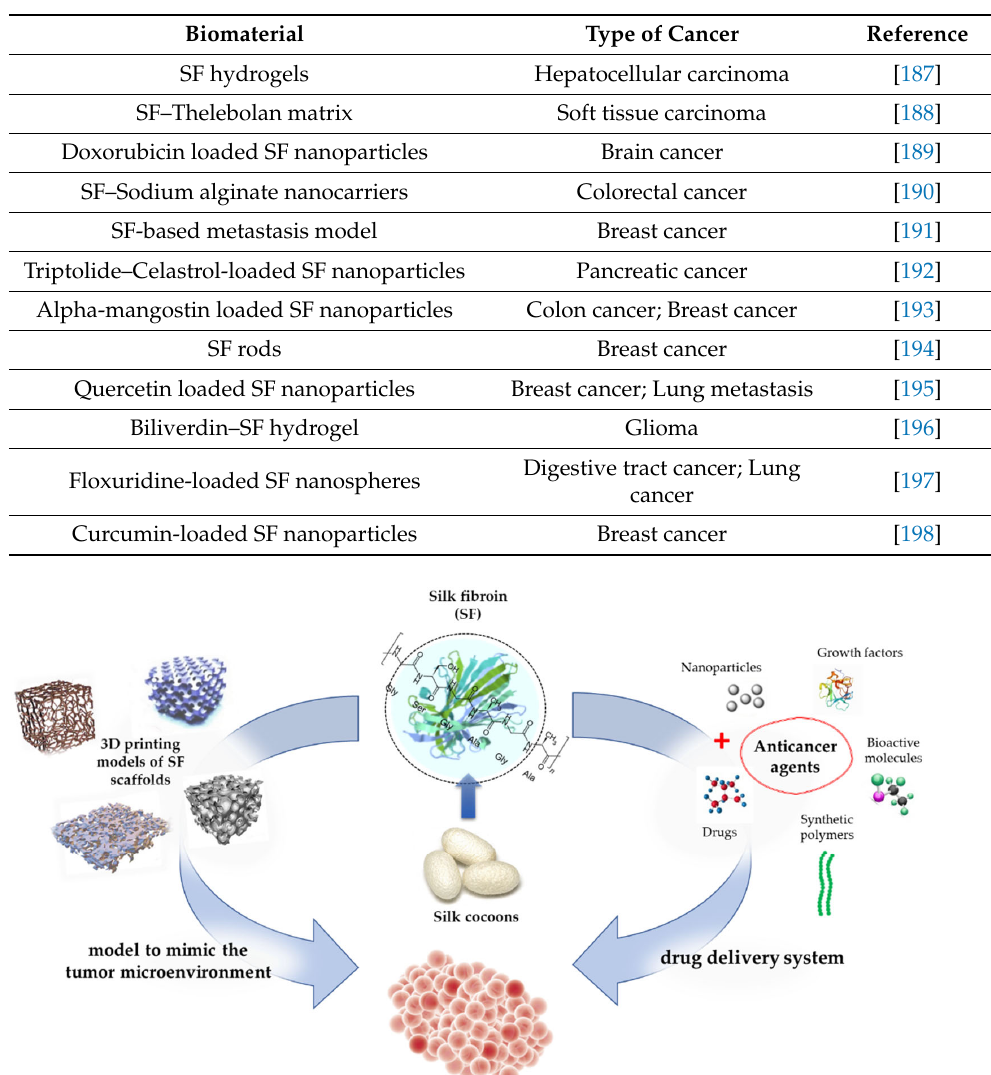
Table 3. SF-based biomaterials used in cancer therapy.